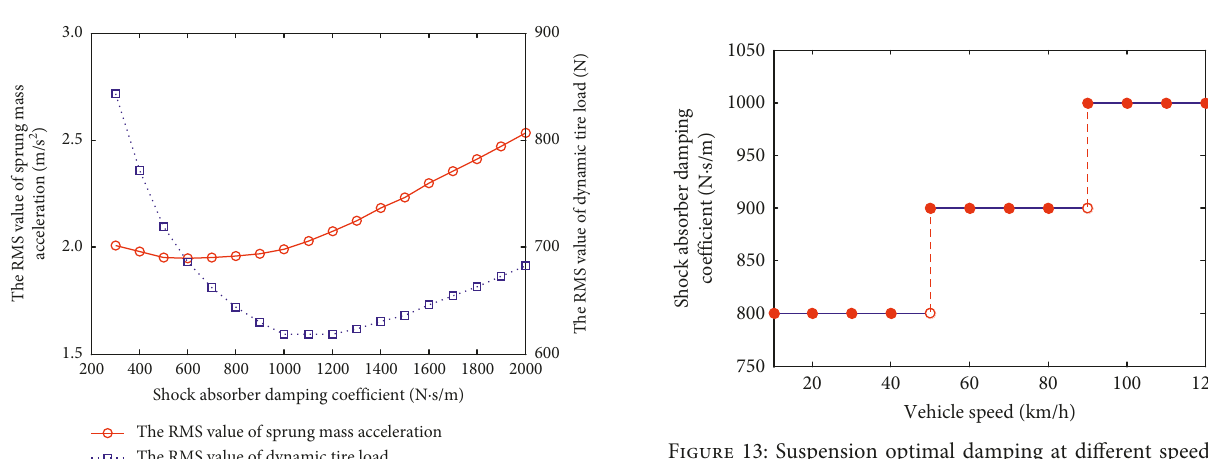
Figure 12: Relationship between the variable damping and vehicle dynamic performance at 100 km/h speed.